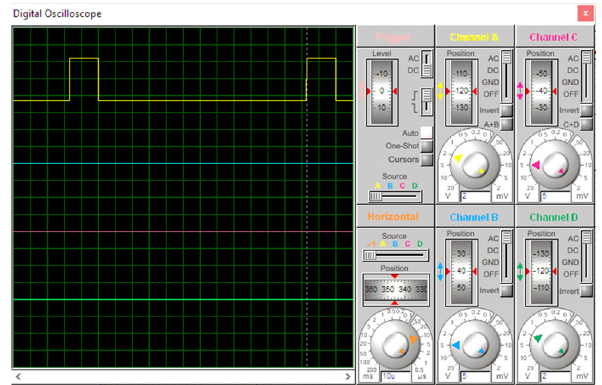
Figure 4: Pulse signal on